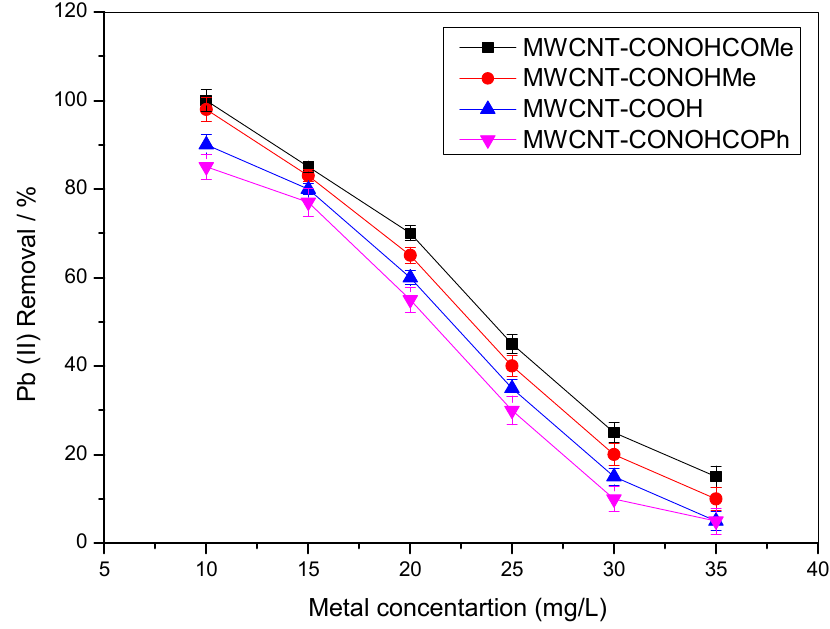
Figure 9. Effect of initial concentration of Pb(II) on Pb(II) removal % using 10 mg functionalized carbon nanotubes and a pH of 8.0 for 50 min at 30 °C.